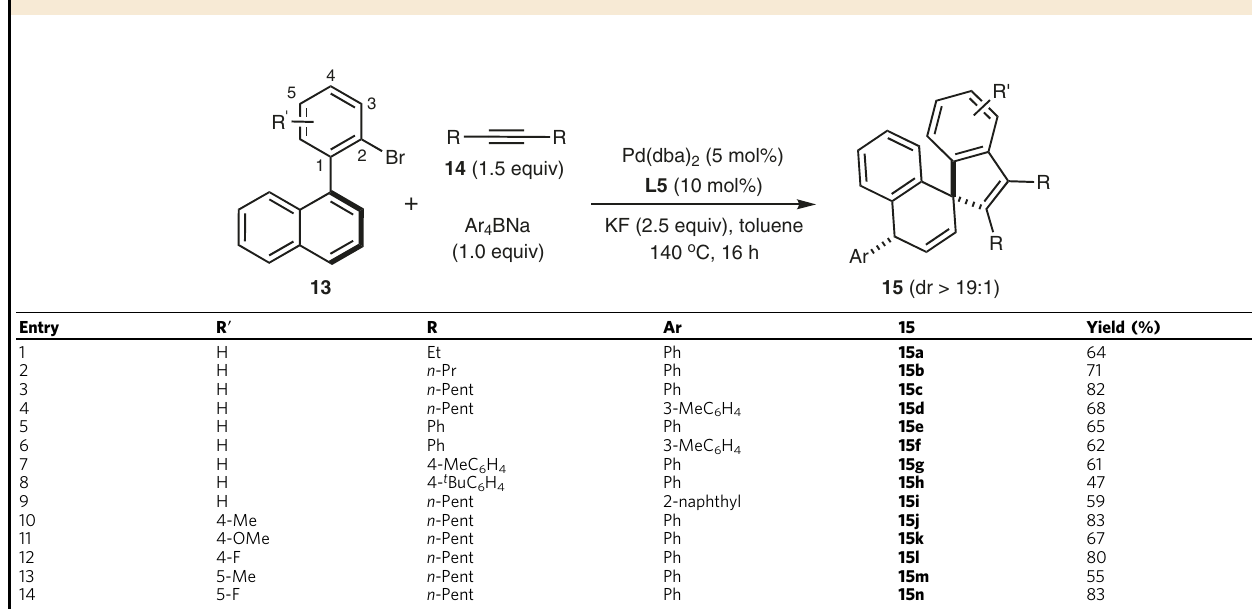
Table 3 Three-component dearomative 1,4-vinylarylation reaction a .